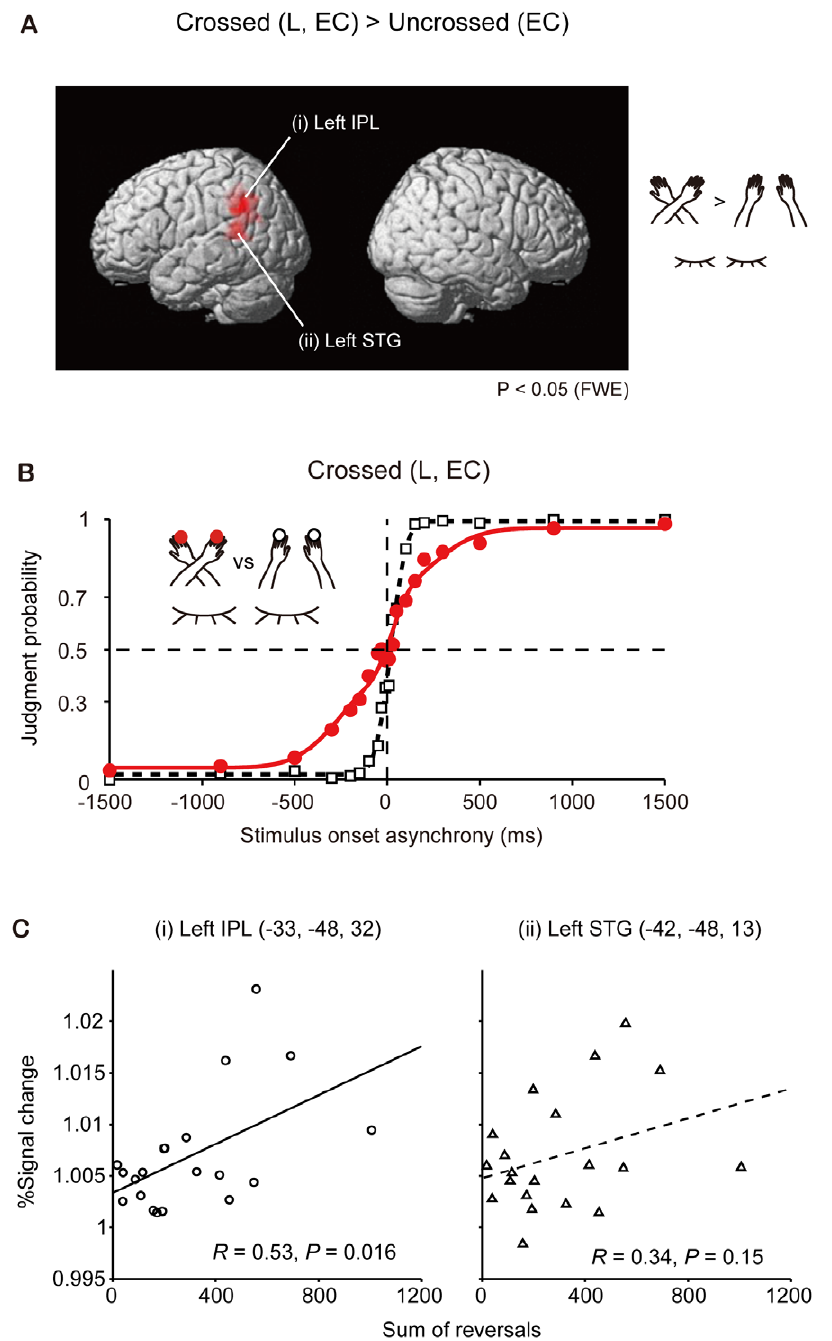
Figure 3. Functional imaging and behavioral data in the left-over-right-arm crossed condition with eyes closed (Crossed L, EC). ( A ) Crossed L–Uncrossed contrasts calculated using functional imaging: [(EC Crossed L) 2 (EC Uncrossed); P , 0.05, FWE, extent volume . 90 voxels]. The contrasts were masked by the arms-crossed condition at P =0.05. (i) The left inferior parietal lobule (IPL, 2 33, 2 48, 32), and (ii) the left superior temporal gyrus (STG; 2 42, 2 48, 13). Each peak (in Talairach coordinates) was derived from statistical parametric mapping. ( B ) Tactile TOJs in the Crossed L condition (solid symbols) and Uncrossed (open symbols) conditions. The judgment probability (ordinate) that participants reported their left hand to have been stimulated second is plotted against the stimulus onset asynchrony (SOA; abscissa). The black dashed and red solid functions highlight the results of the model fitting [11] under the Uncrossed and Crossed L conditions, respectively. Each dot represents the averaged data from the 20 participants. ( C ) Panels highlighting the correlation between signal changes in each region of interest (IPL: Inferior parietal lobule, STG: superior temporal gyrus) and the sum of the reversals.